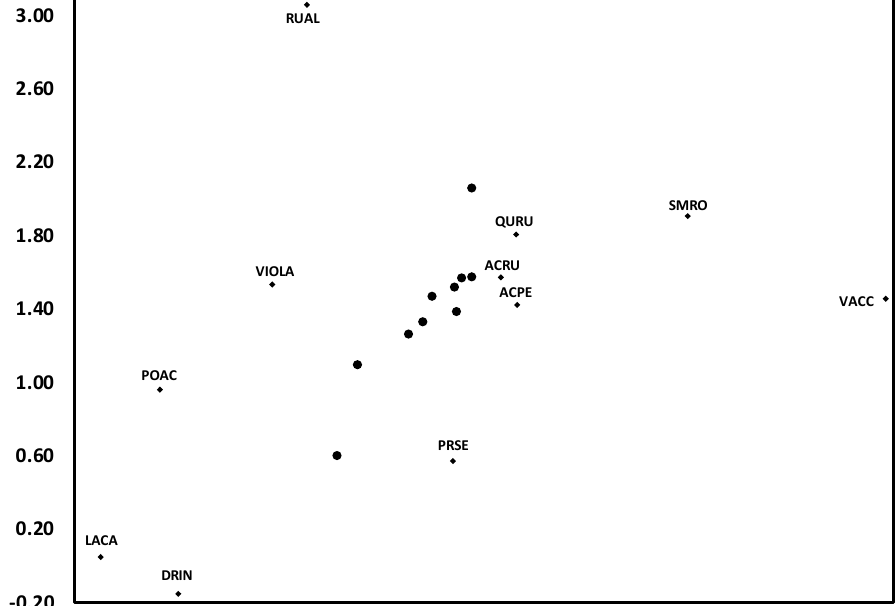
Figure 2. Detrended correspondence analysis (DCA) for herbaceous layer communities from 1991 to 2014 on reference WS4. Depicted are prominent species, along with centroids as shown in Figure 1. Species codes are as follows: ACPE ( Acer pensylvanicum ), ACRU ( A . rubrum ), DRIN ( Dryopteris intermedia ), LACA ( Laportea canadensis ), POAC ( Polystichum acrostichoides ), PRSE ( Prunus serotina ), QURU ( Quercus rubra ), RUAL ( Rubus allegheniensis ), SMRO ( Smilax rotundifolia ), VACC ( Vaccinum spp.), and VIOLA ( Viola